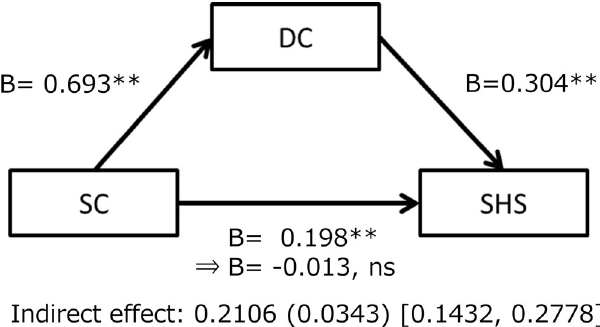
Fig. 3 Relationship between epistemic curiosity and subjective wellbeing. All B ’ s represent unstandardized regression coef fi cients obtained through bootstrapping using 10,000 resamples. The range in brackets represents the 95% CI of the indirect effect. ** p